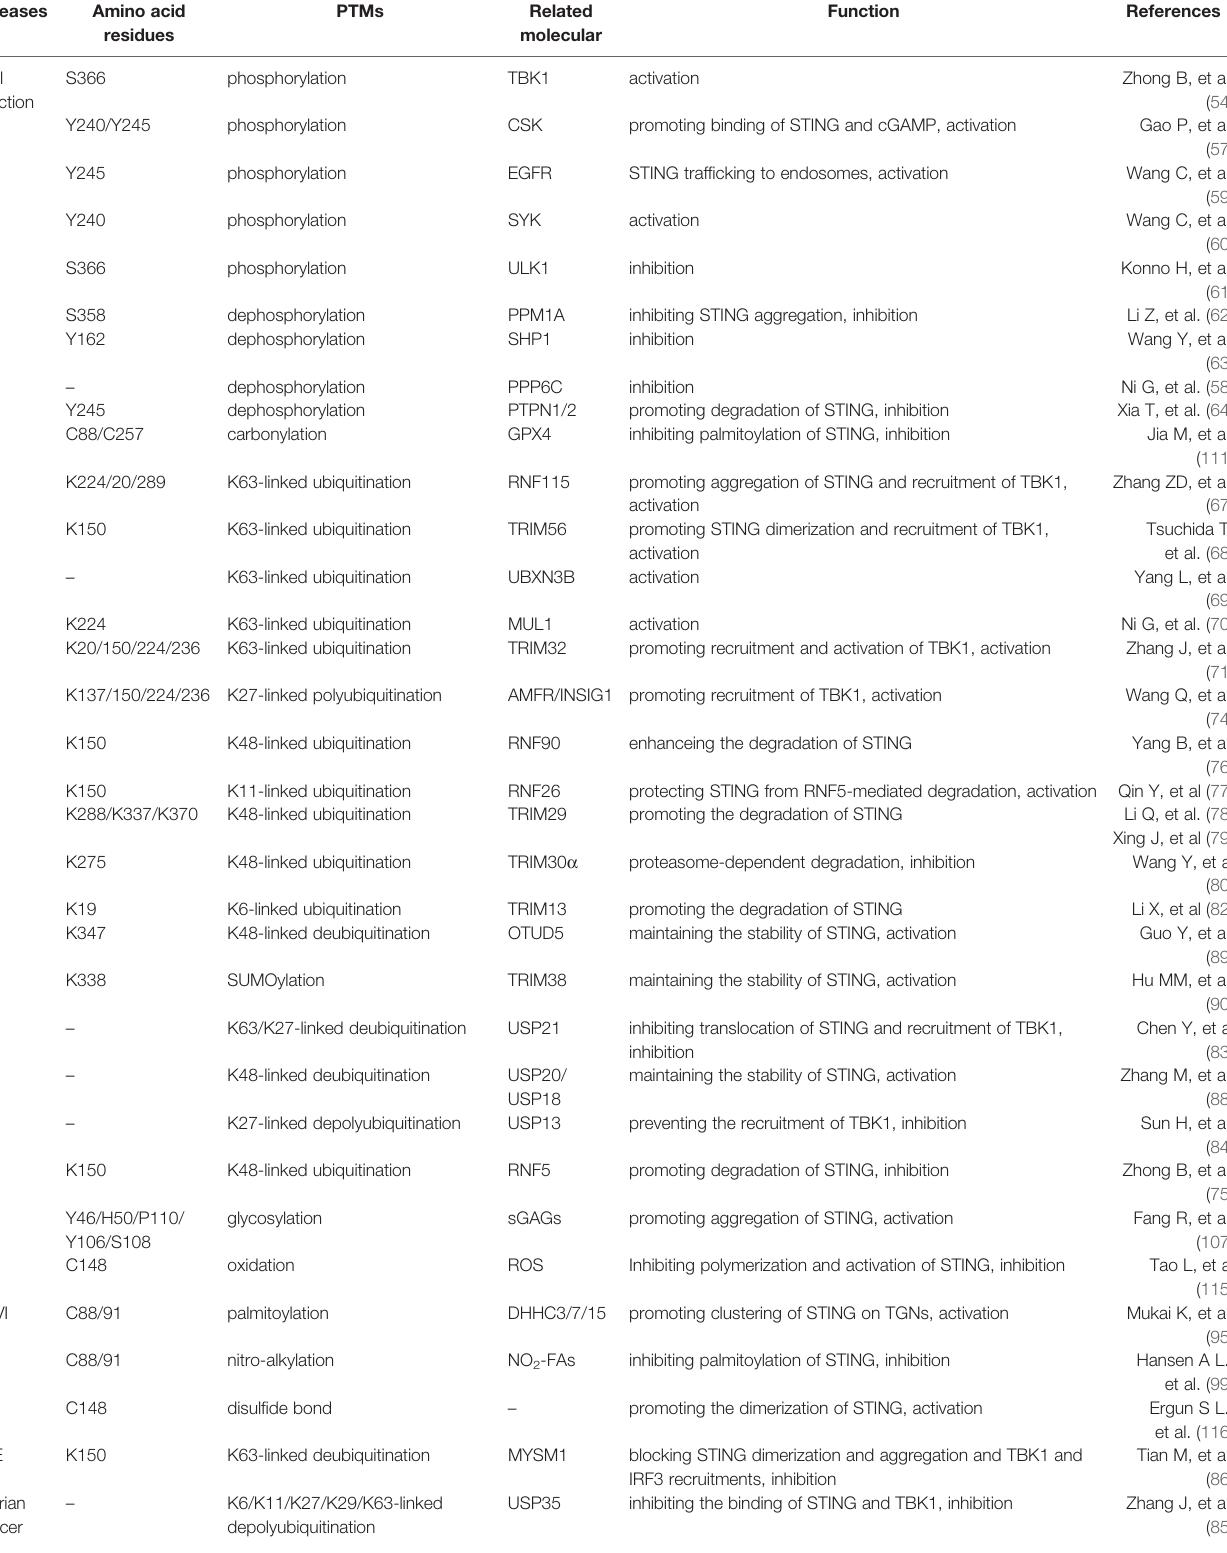
TABLE 1 | PTMs of STING and associated study models.